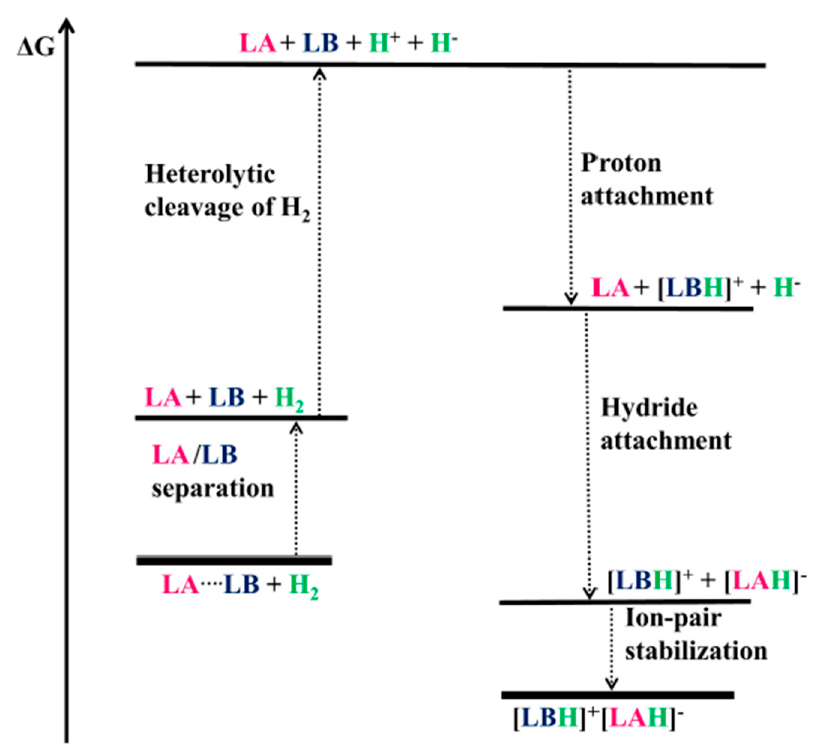
Figure 3. Partitioning scheme of the reaction of free energy to interpret the thermodynamic requirement of H 2 activation by FLP.